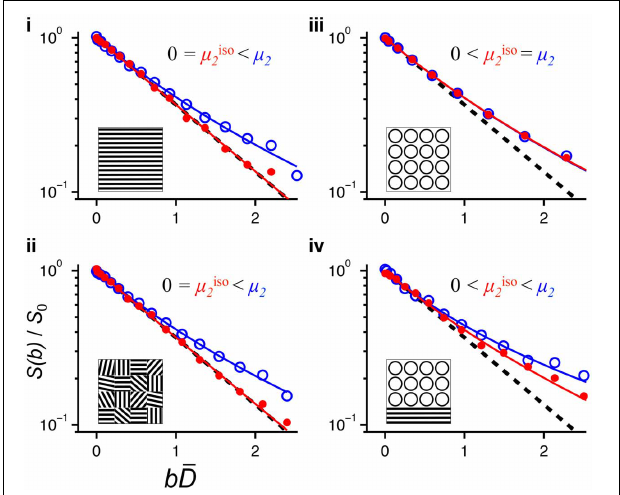
FIGURE 6 | Normalized signal S ( b )/ S 0 vs. normalized diffusion weighting bD for selected pixels in Figure 5. The roman numerals of the panels correspond to the pixel labels in Figure 5A . Powder-averaged directional and isotropic data is shown with open blue and solid red circles, respectively. The solid lines indicate fits of Equation (25) to the data using S 0 , D , μ 2 , and μ iso 2 as adjustable parameters. The dashed lines show the single-exponential decay S / S 0 = exp (– bD ). The inserts illustrate the microstructure, with water occupying the white space between the black barriers: ( i ) single-orientation anisotropic, ( ii ) randomly oriented anisotropic domains, ( iii ) water inside and between spherical compartments, and ( iv ) mixed case with spherical compartments and anisotropic domains. The panels are labeled with the characteristic relations between μ 2 and μ iso 2